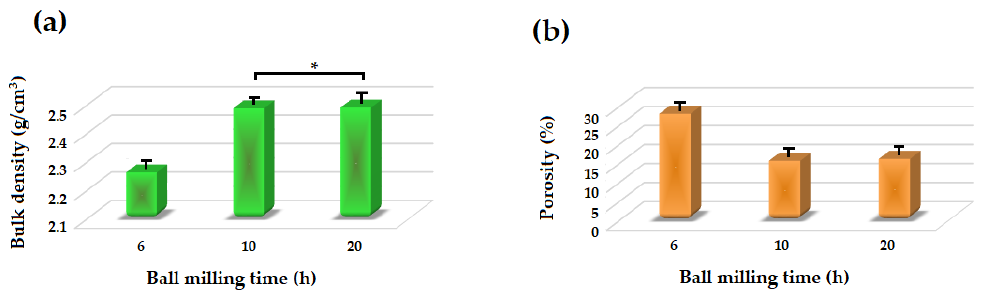
Figure 7. ( a ) Bulk density and ( b ) apparent porosity of different samples (* not significantly different).